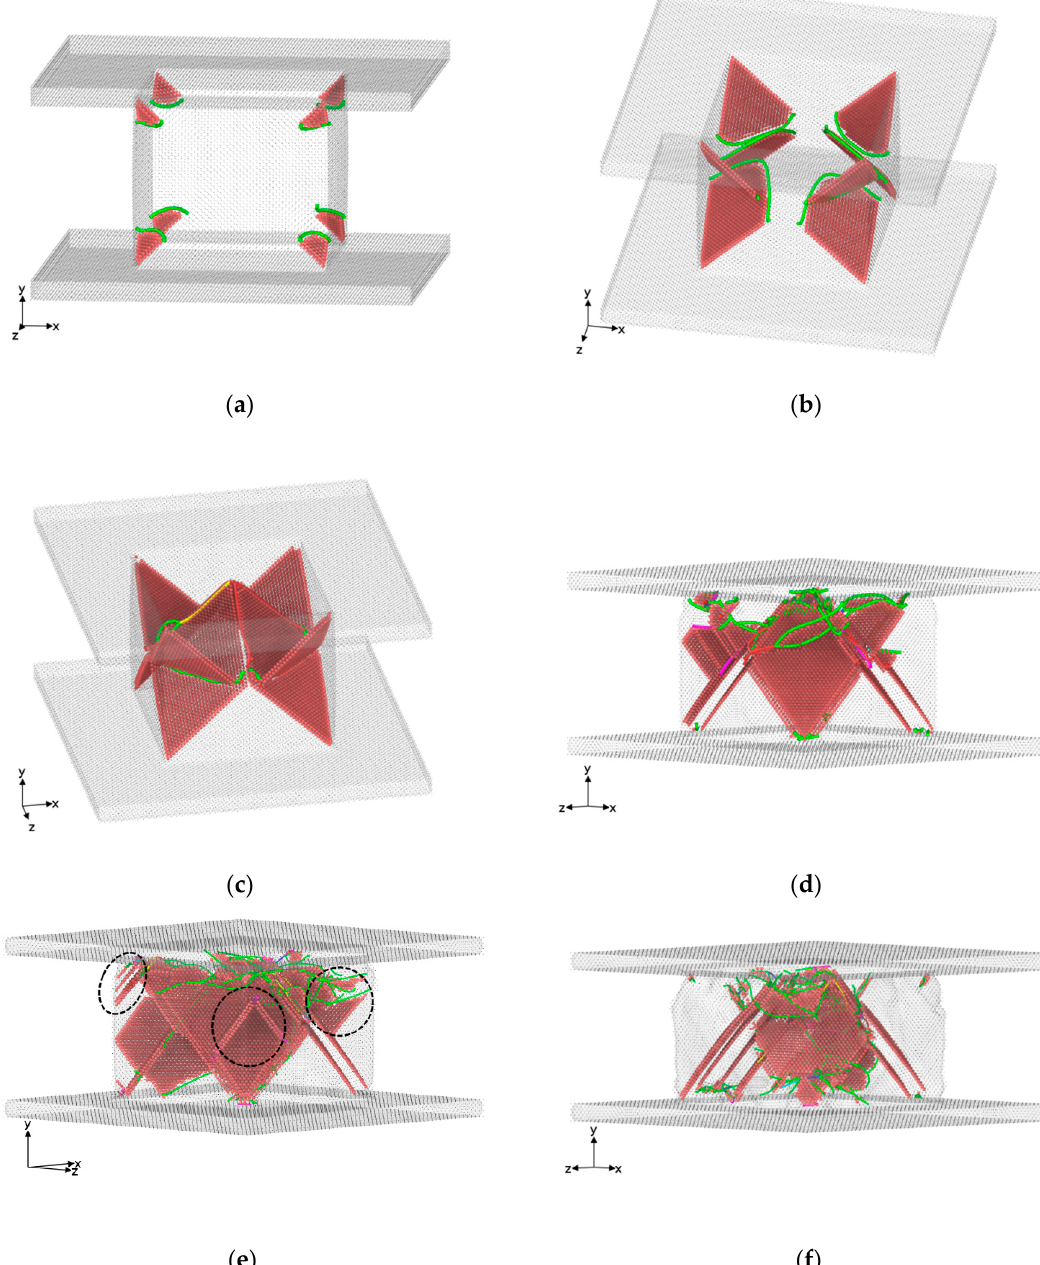
Figure 13. Deformation patterns in a simulated < 001 > single crystal with h / d = 1 and {100} lateral faces at a sequentially increasing strain of ( a ) 7.79%; ( b ) 7.89%; ( c ) 7.94%; ( d ) 12.59%; ( e ) 14.2% and ( f ) 21.5%.